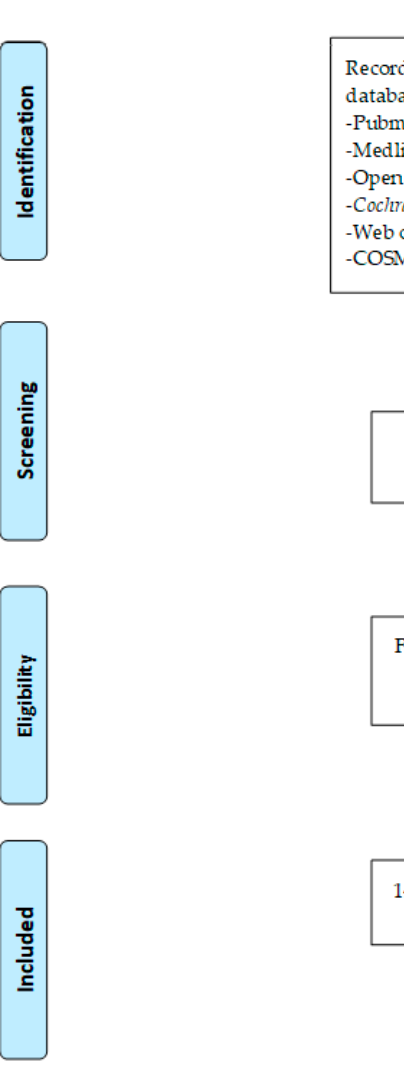
Figure 1. Flow chart diagram of the study selection.